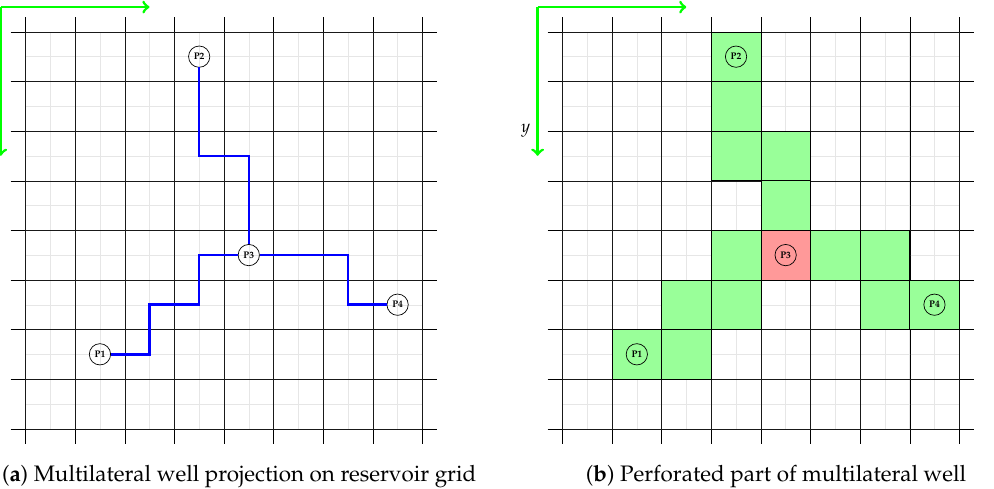
Figure 9. Approximation of wells’ trajectories in a simulation grid.